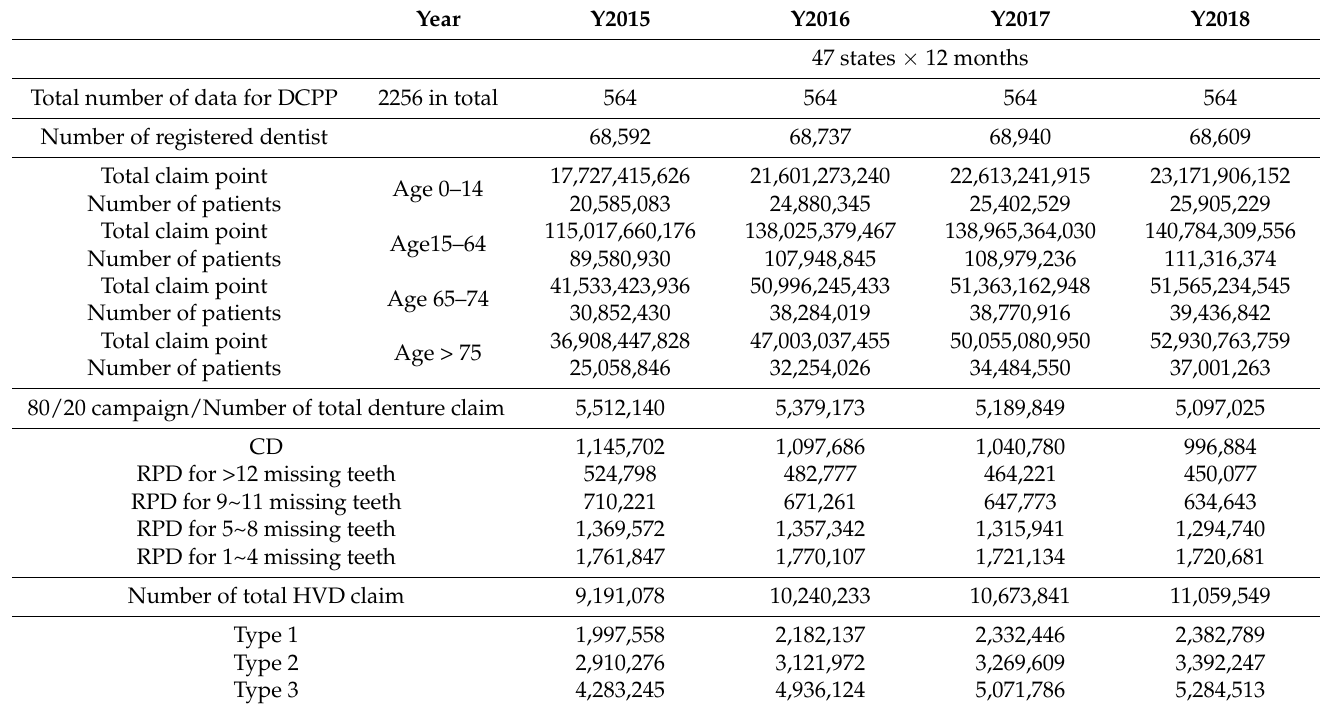
Table 1. Summary of numbers of data